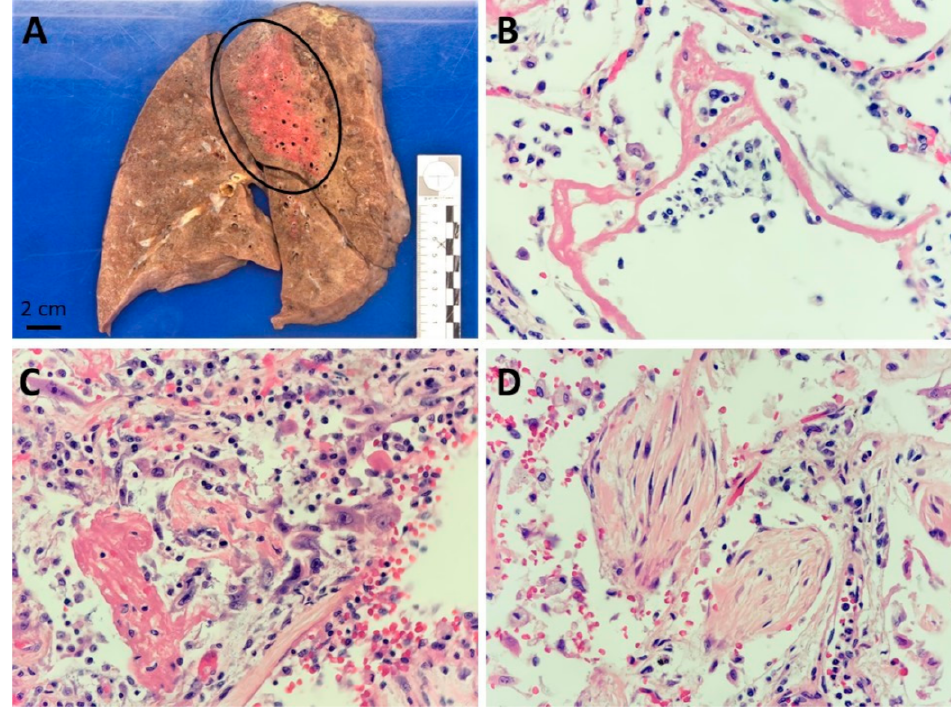
Figure 1. Lung pathology associated with SARS-CoV-2 infection: ( A ) Sagittal macroscopic section of a formalin fixed right lung, showing a condensed area in the posterior part of the upper lobe (encircled area), patient n 7; ( B ) Alveolar damage at exudative stage with prominent eosinophilic hyaline membranes (HE 400 × ), patient n 2; ( C ) Alveolar damage at proliferative stage with proliferation of alveolar pneumocytes (HE 400 × ), patient n 10; ( D ) Organizing pneumonia with intra-alveolar fibroblast plugs (HE 400 × ), patient n ◦